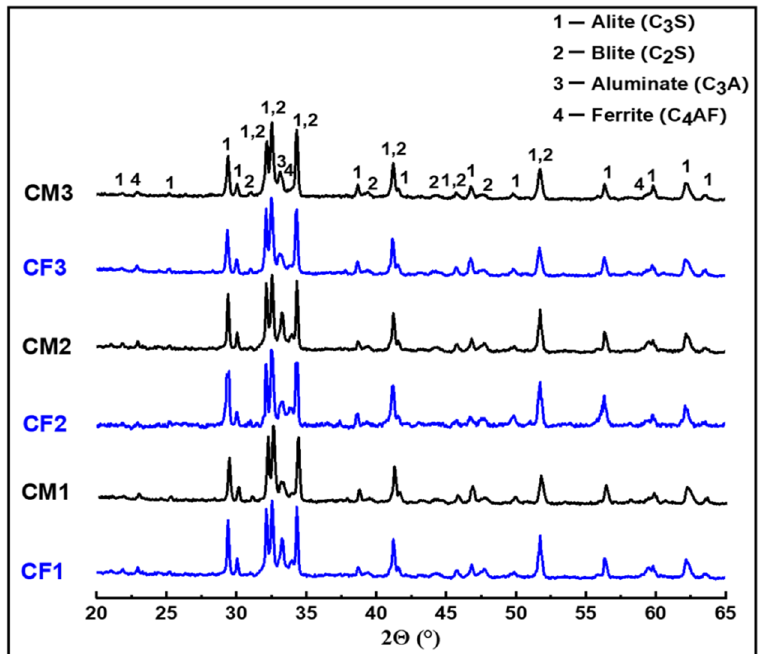
Figure 9. XRD patterns of the prepared clinkers.